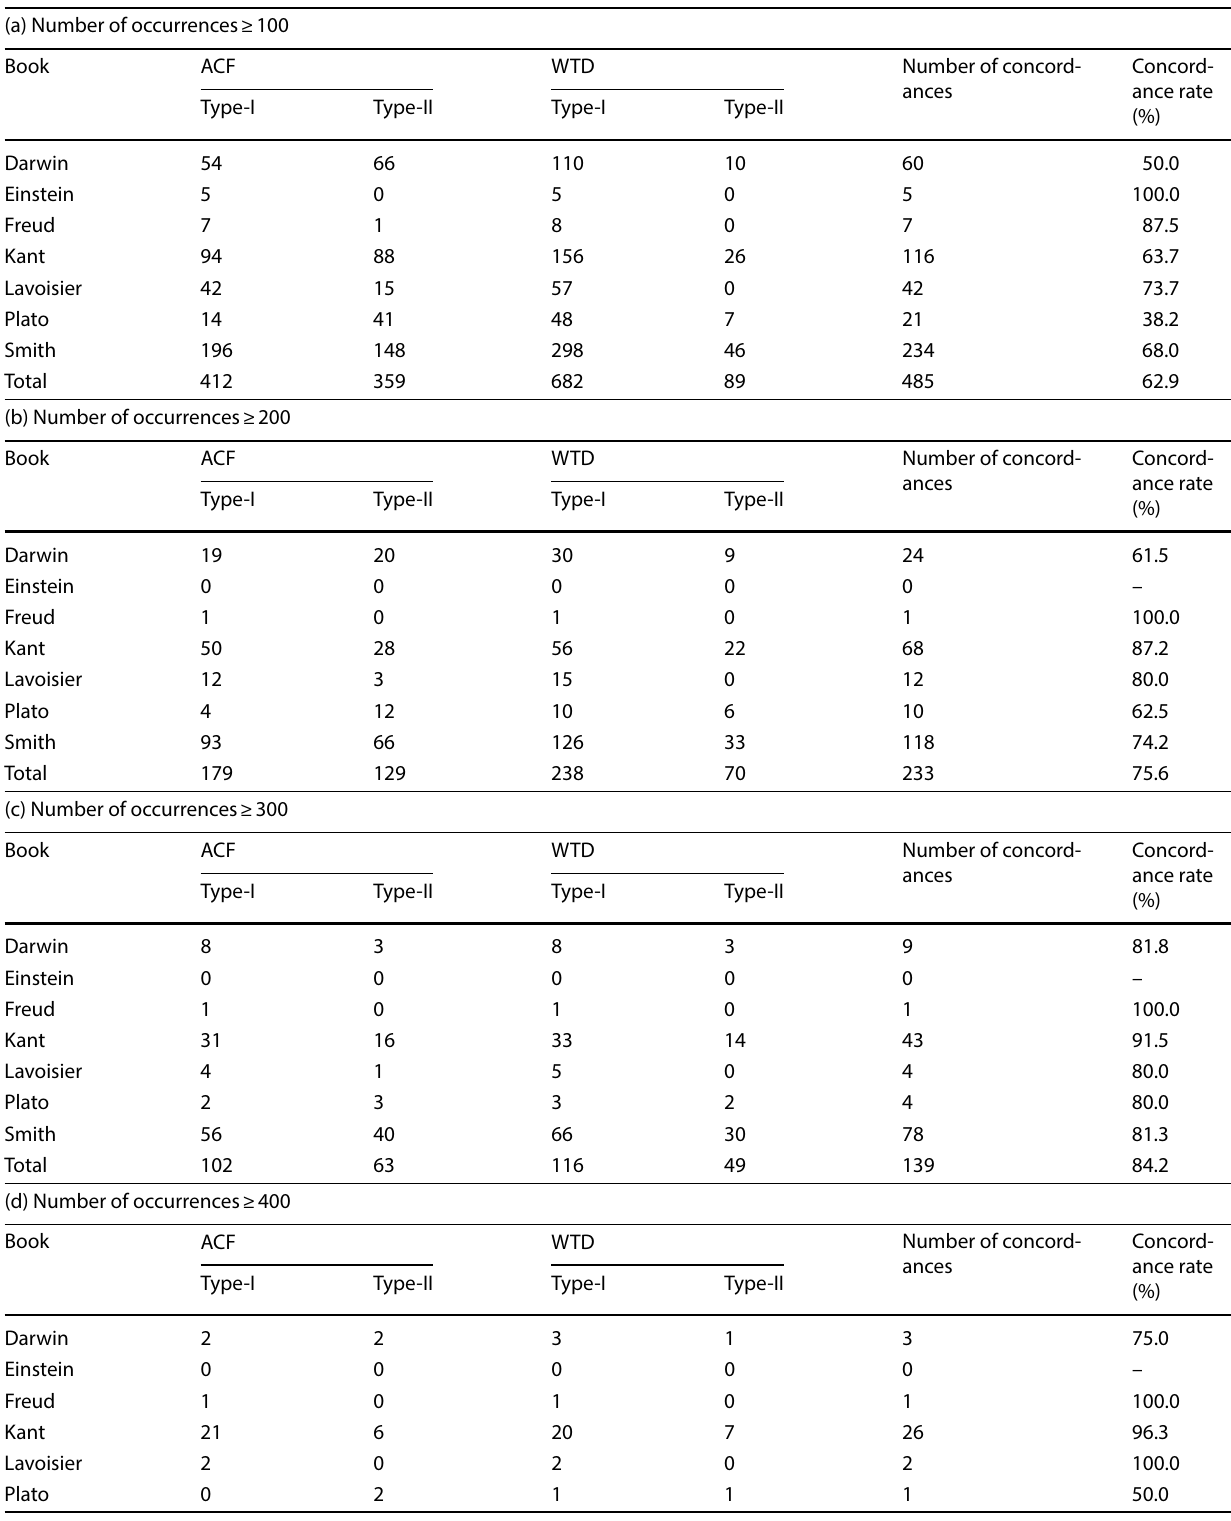
Table 3 Results of classifying word type for frequent words appear- ing in the 7 academic books. The classifications were made by using the two different types of curve fittings, namely, fitting to ACFs and to WTDs. Numbers of words that are classified into Type- I and Type-II are shown in the table for each of the two classifica-